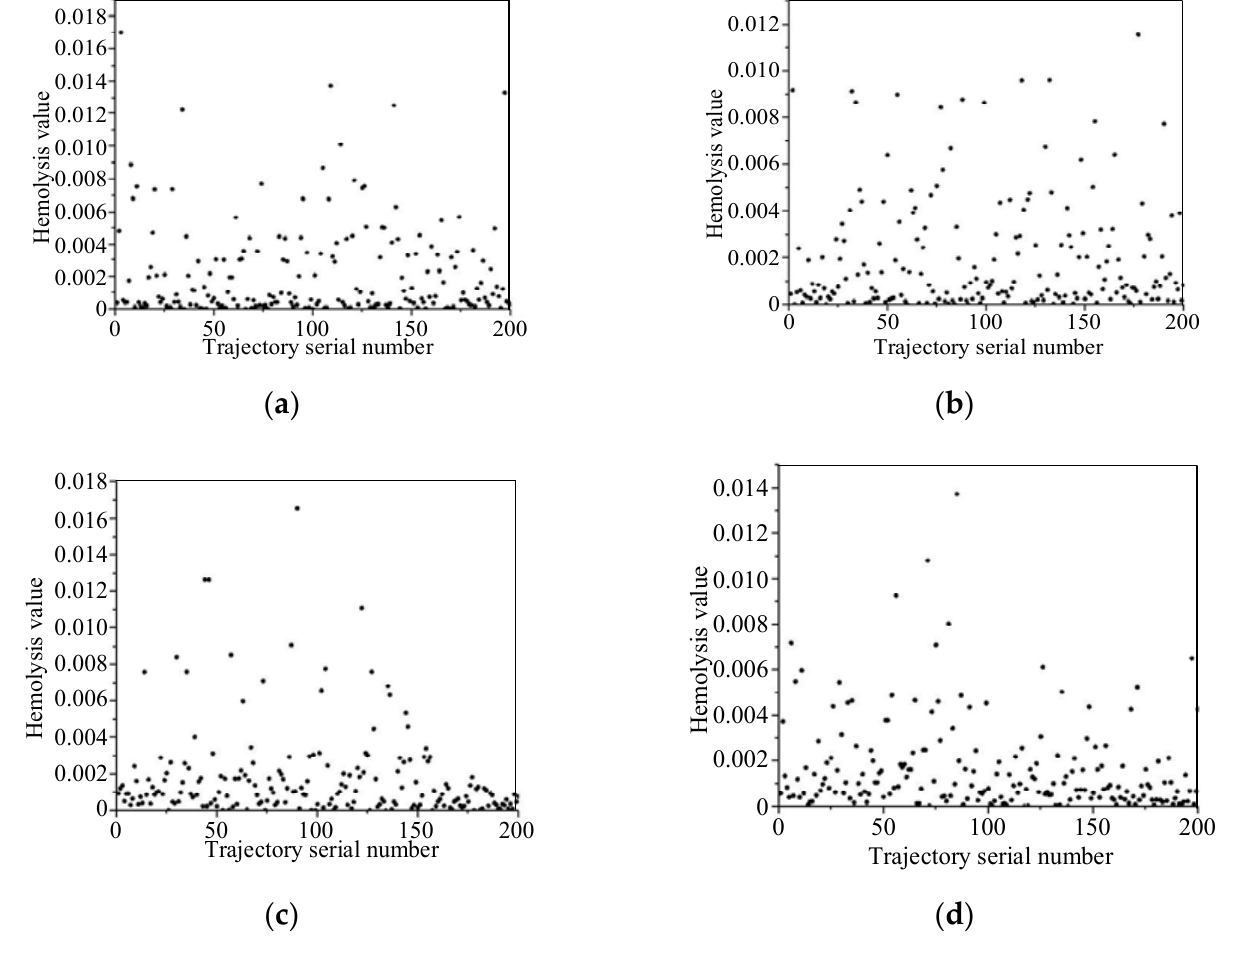
Figure 16. Distribution of hemolysis prediction values for radial clearance of ( a ) 0.3 mm, ( b ) 0.4 mm, ( c ) 0.5 mm, and ( d ) 0.6 mm.